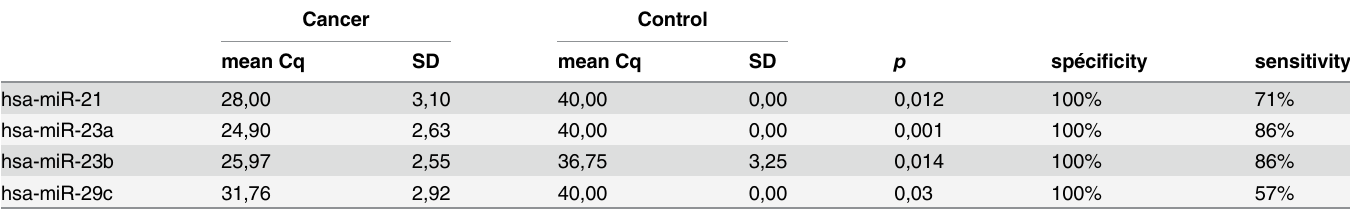
Table 2. Average Cq values, sensitivity and specificity of the candidate microRNAs.